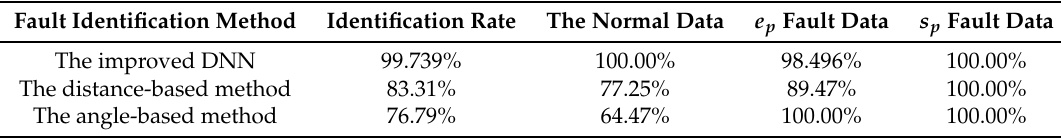
Table 7. The identification rates of various